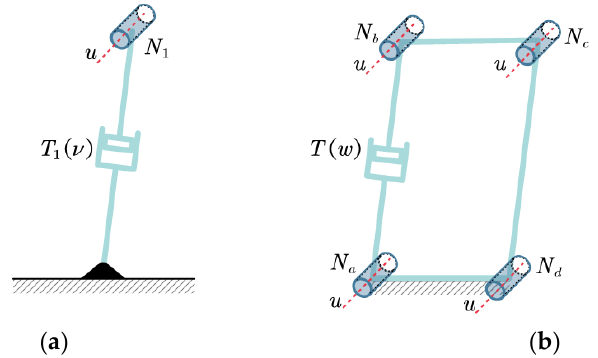
Figure 1. Configuration evolution ( a ) single-branch PR mechanism ( b ) RR-RPR mechanism with parallelogram branches.